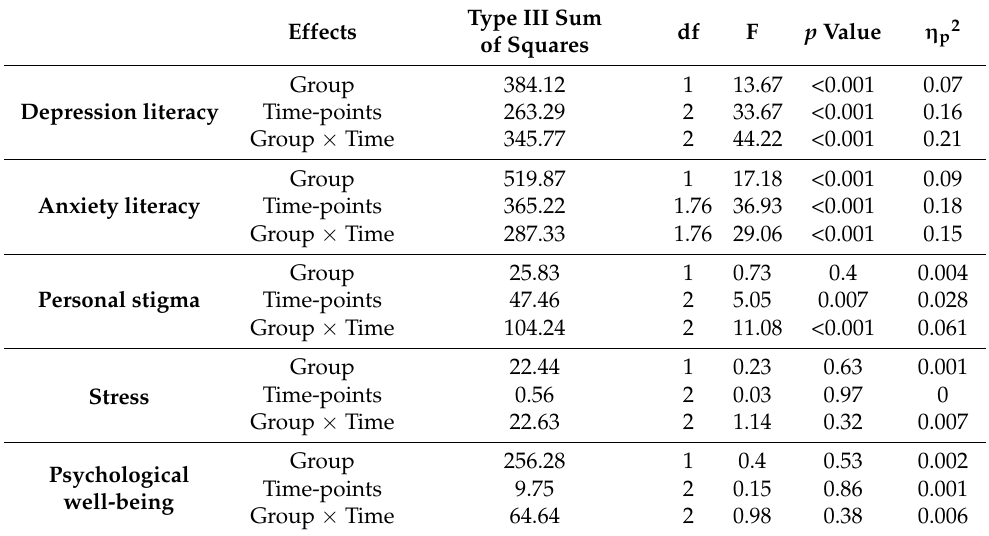
Table 2. Comparison of outcomes (depression literacy, anxiety literacy, personal stigma, stress, psychological well-being) between 2 groups over time.